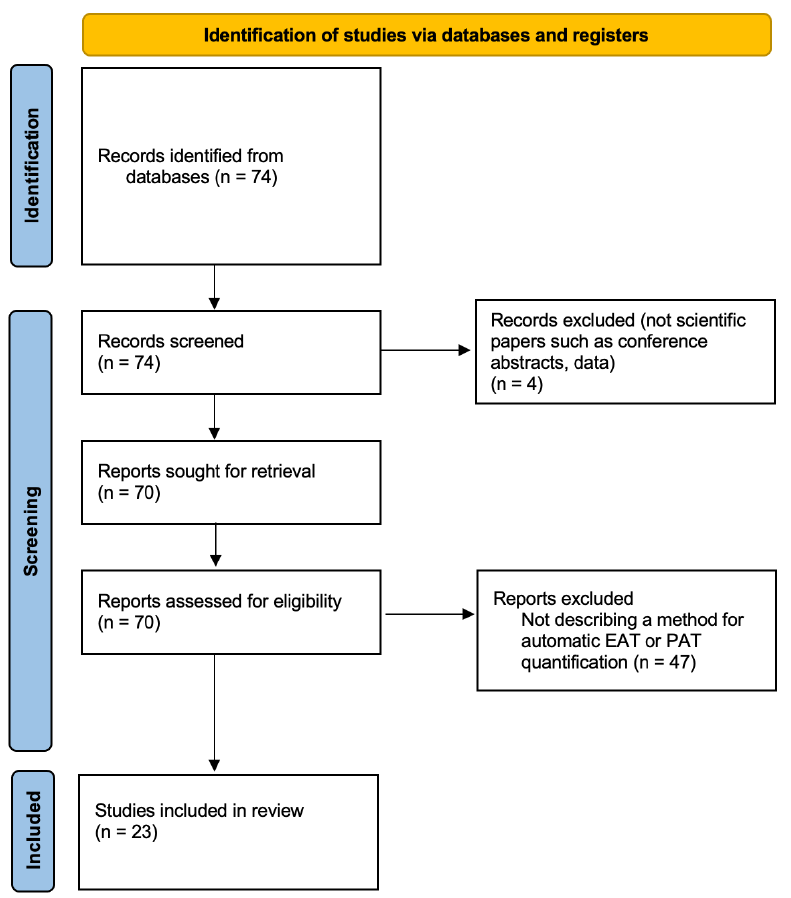
Figure 1. PRISMA flow diagram of our review